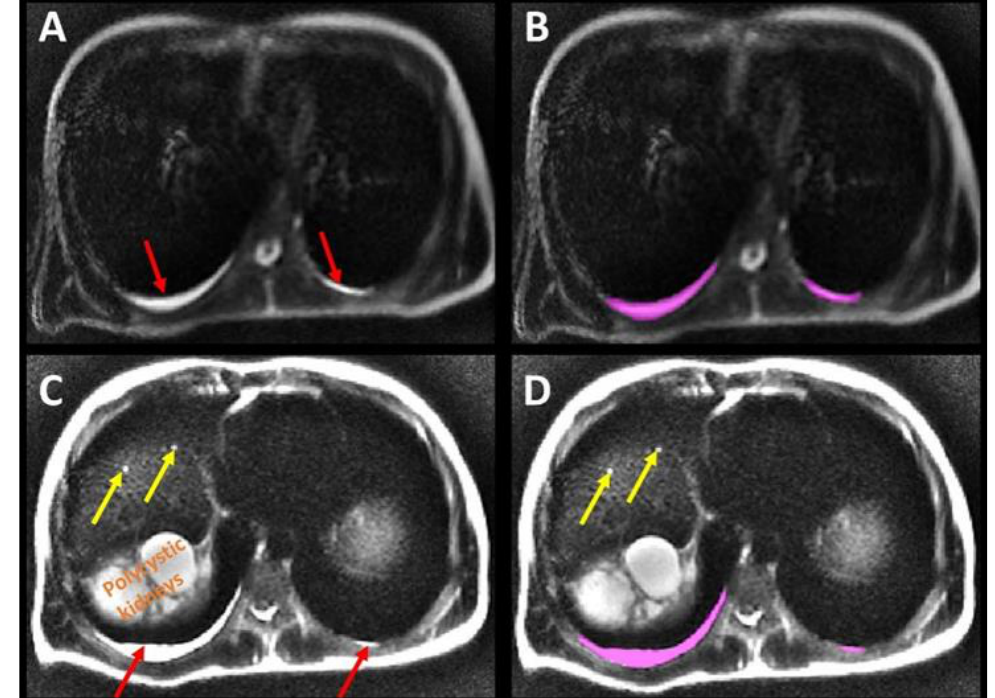
Figure 1. Axial T2 weighted images show pleural fluid (red arrows on ( A , C )) which was measured by annotating the fluid, ( B , D ), in the thoracic cavity (pink label) to determine its volume. Liver cysts (yellow arrows) and the superior pole of the polycystic right kidney were also observed on the more inferior slices, ( C , D ).